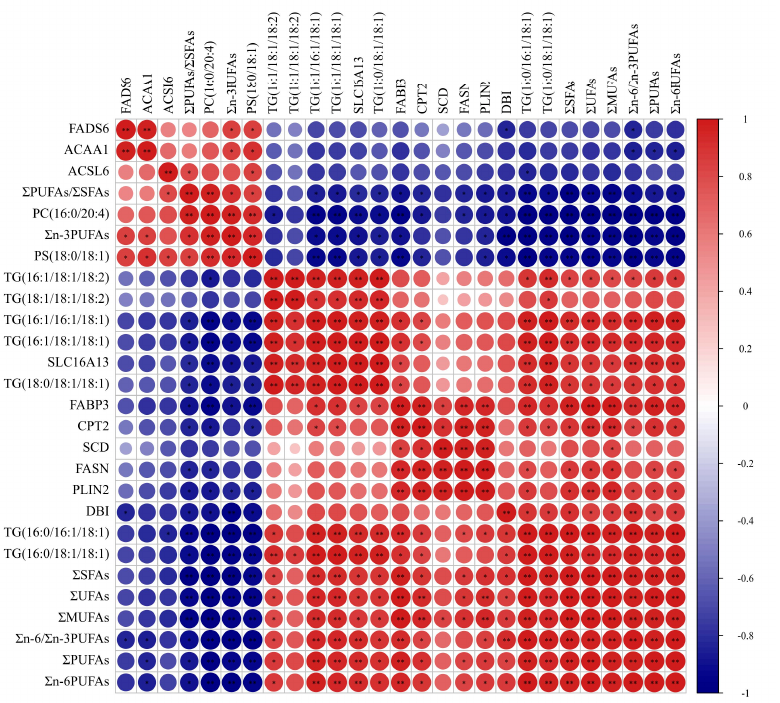
Figure 6. The results of the Pearson correlation analysis for the fatty acids, SDLs and DEGs in yak’s LD. Red and blue circles show the significant positive and negative correlation, respectively. When the color is darker the correlation is higher. * shows p < 0.05; ** shows p < 0.01.